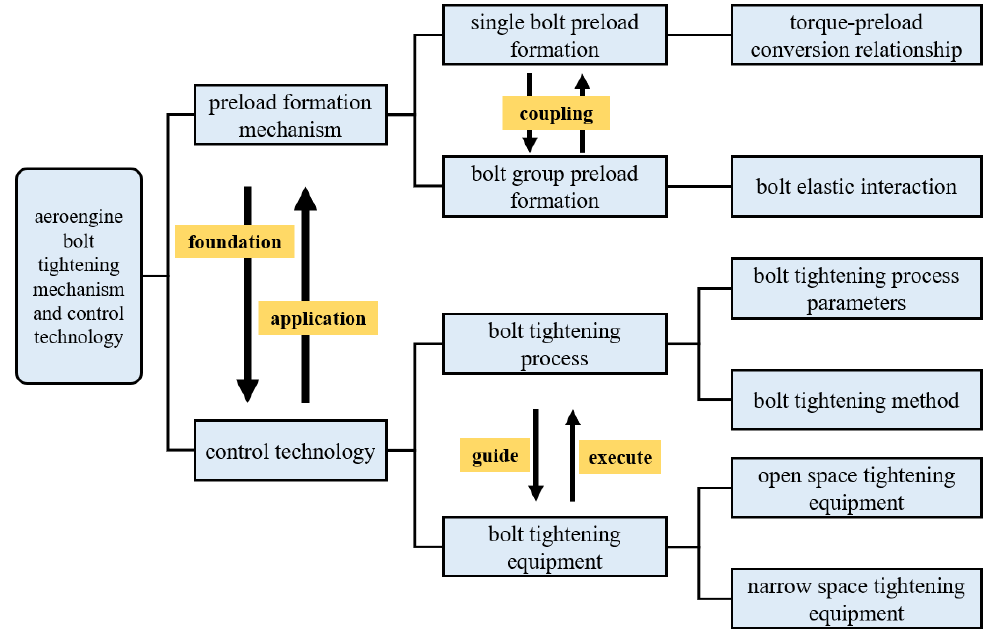
Figure 24. Diagram of the relationship between the bolt tightening mechanism and the control tech-